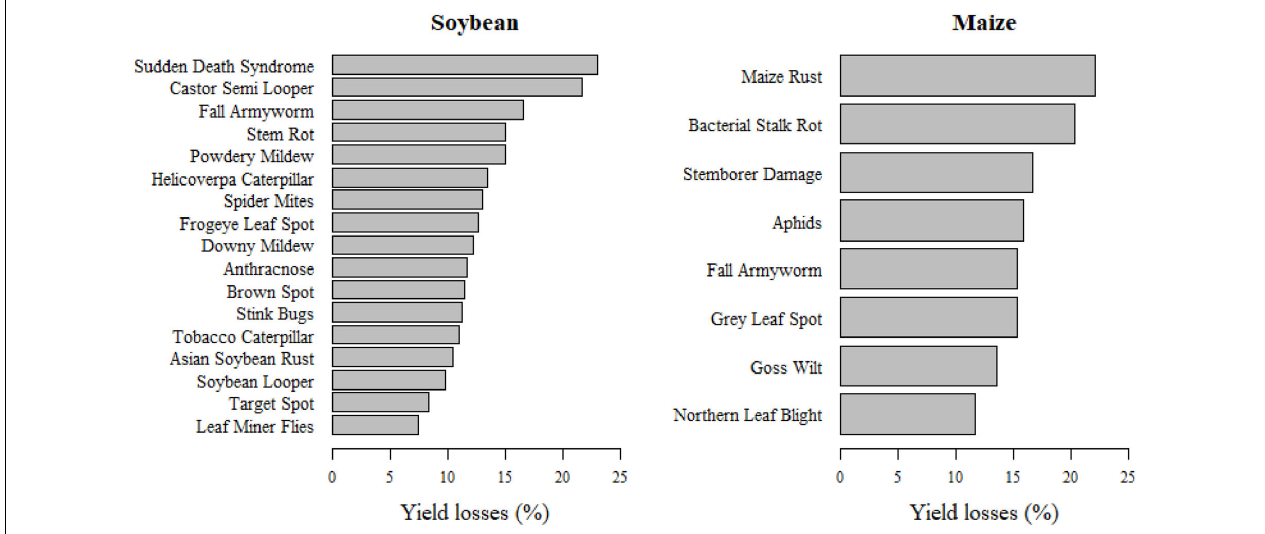
FIGURE 8 | Expected soybean and maize yield losses (%) in Mato Grosso and Pará, Brazil, according to individual pathogens and animal